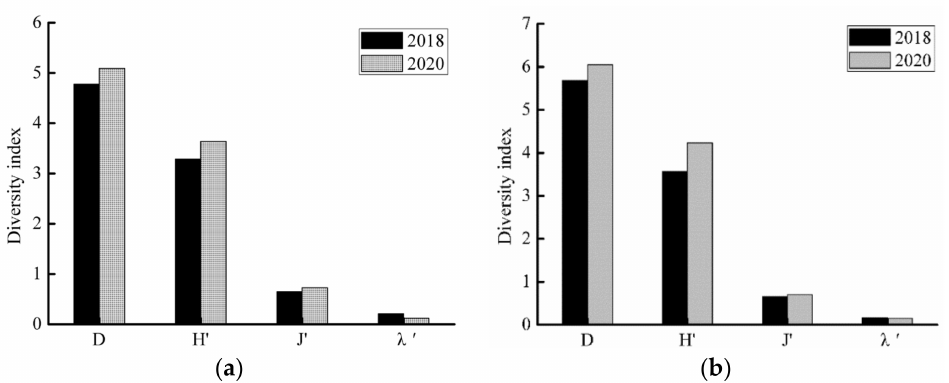
Figure 6. Variation in values of the fish community diversity index in Shishou ( a ) and Jiayu ( b ) river reaches in different years. D : Margalef species richness index; H (cid:48) : Shannon − Wiener diversity index; J (cid:48) : Pielou’s evenness index; λ (cid:48) : Simpson dominance